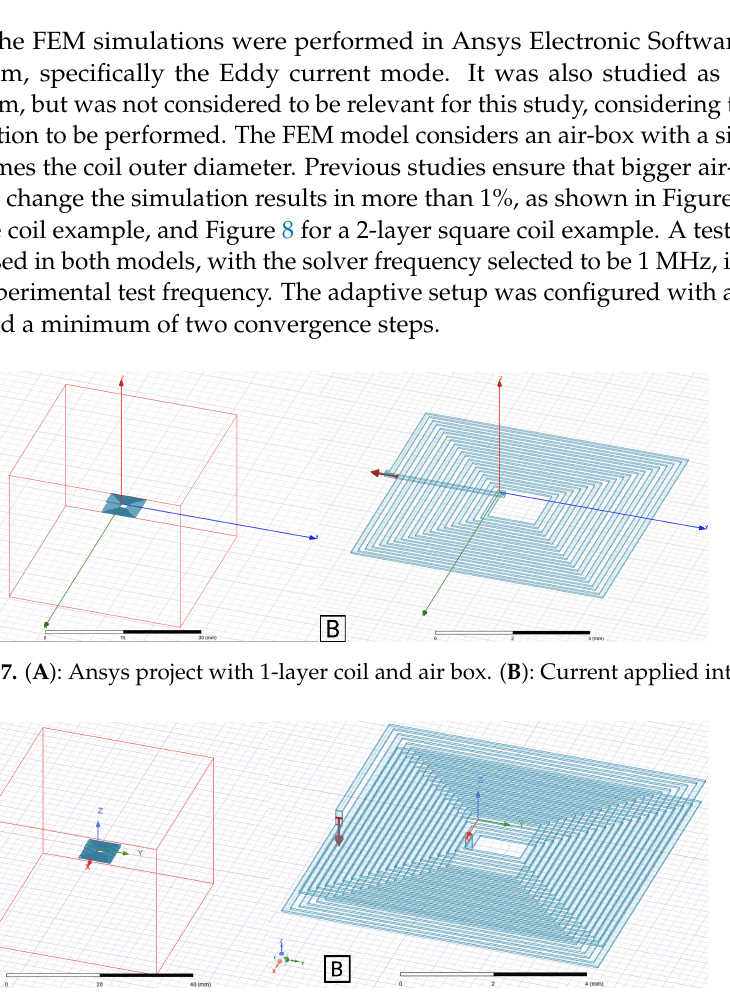
Figure 6. 2-layer coil layouts simulated in Ansys Software. Segments per turn: ( A ): 4; ( B ): 6; ( C ): 8; ( D ): 10.